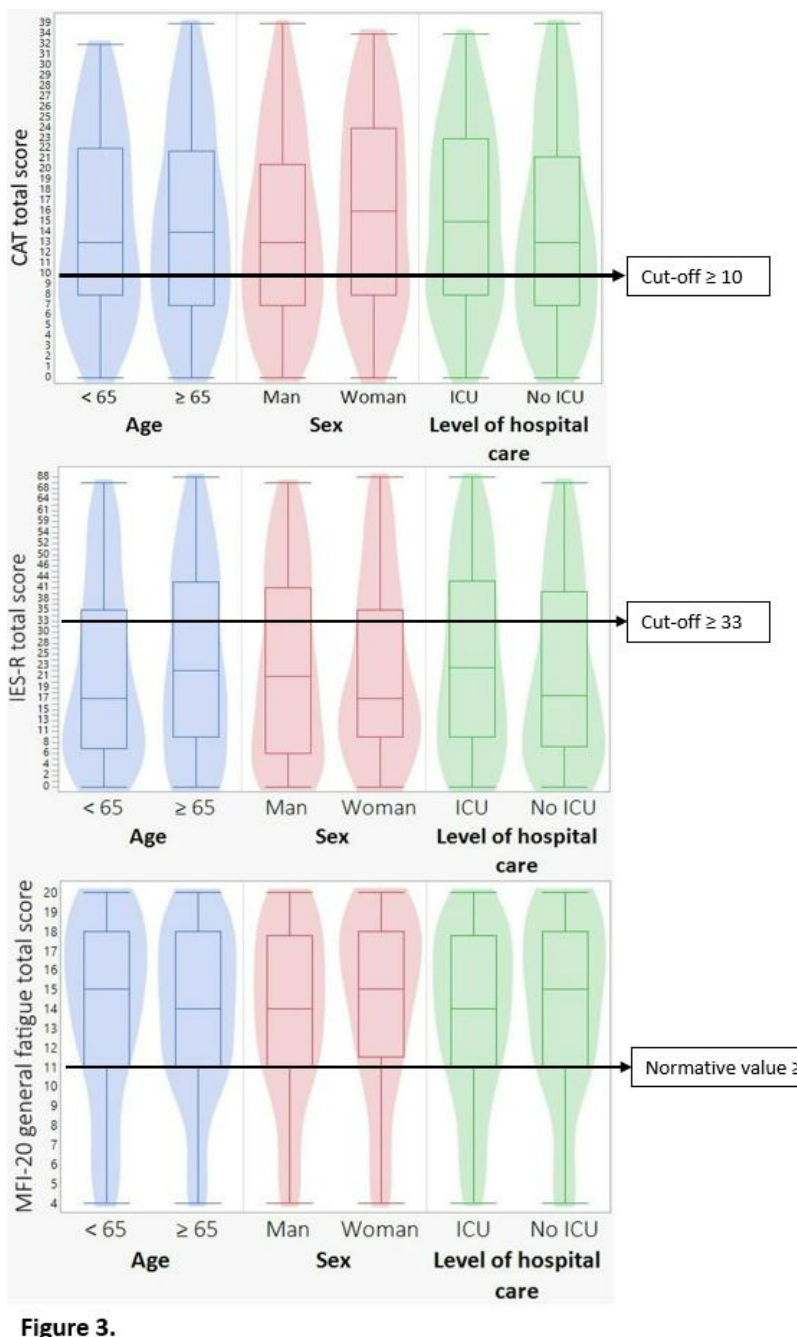
Figure 3. Results on CAT, IES-R and MFI-20 depending on age, sex and level of hospital